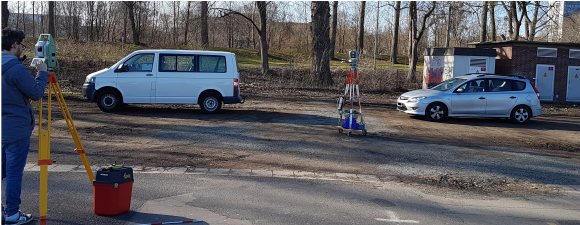
Figure 2. The setting for the measurements: the total station (left), both cars (in the back) and the scanners at the dynamic rack (center) the rack with the two LiDAR Velodyne HDL-64E S2 and VLP- 16 between the vehicles (measurement scene 0) and the total station, statically placed 10 m in front of the vehicles. The ve- hicle positions were determined by measuring the middle